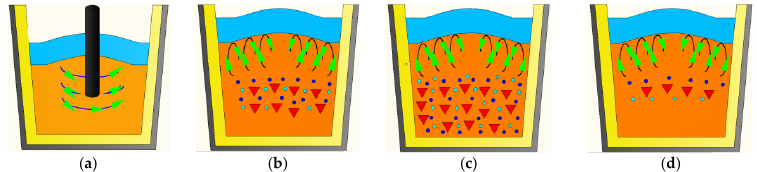
Figure 22. The schematic diagram of slag entrainment to the steel: ( a ) stirring steel by graphite rod; ( b ) normal heat; ( c ) added Na 2 O; ( d ) added Rb 2 O. The blue and orange part of the picture shows molten slag and molten steel respectively; Dots and trangles shows inclusions in steel; The arrows in ( a ) indicates the direction of the stirring of the graphite rod; The arrows in ( b – d ) indicates the flow direction of molten steel when slag entrapment happens during refining process.